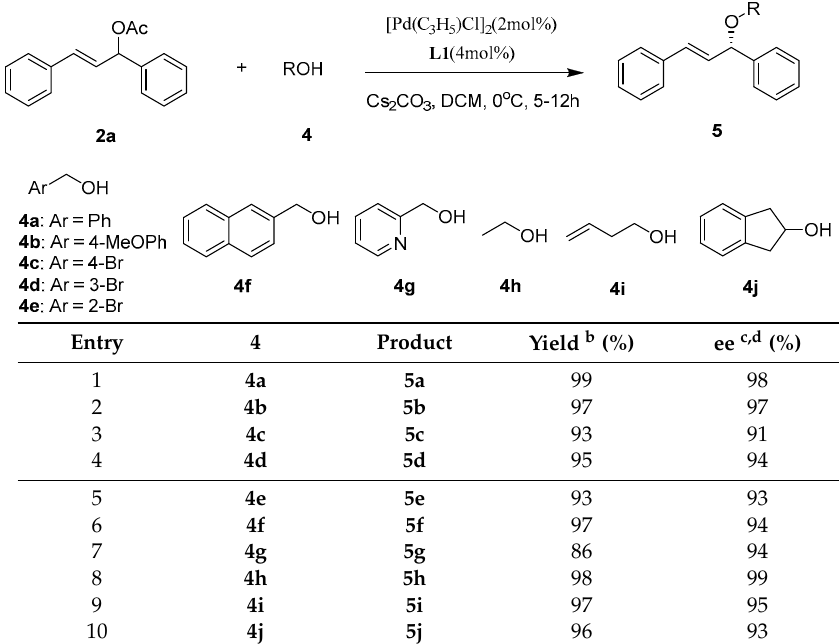
Table 4. Substrate scope of asymmetric allylic etherification. a